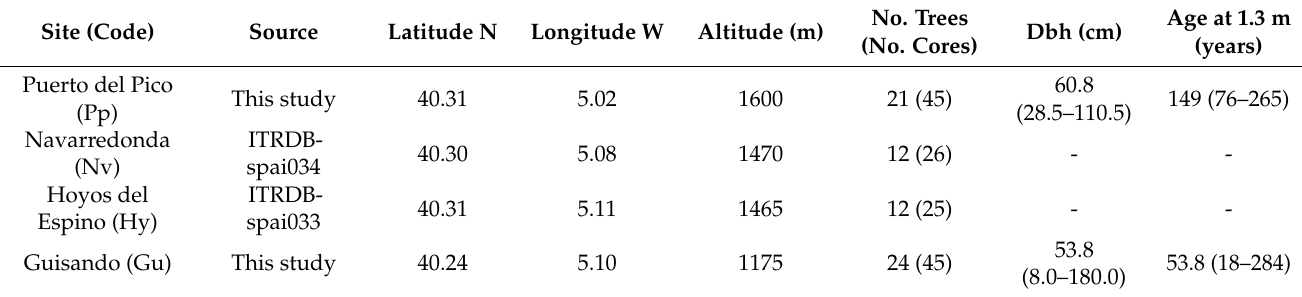
Table 1. Site information on the forests where tree-ring chronologies were developed. Diameter (Dbh) and age values are averages, and their ranges are shown between parentheses. The two ITRDB chronologies were developed by Klaus Richter, and Dbh and age data are not available for them.